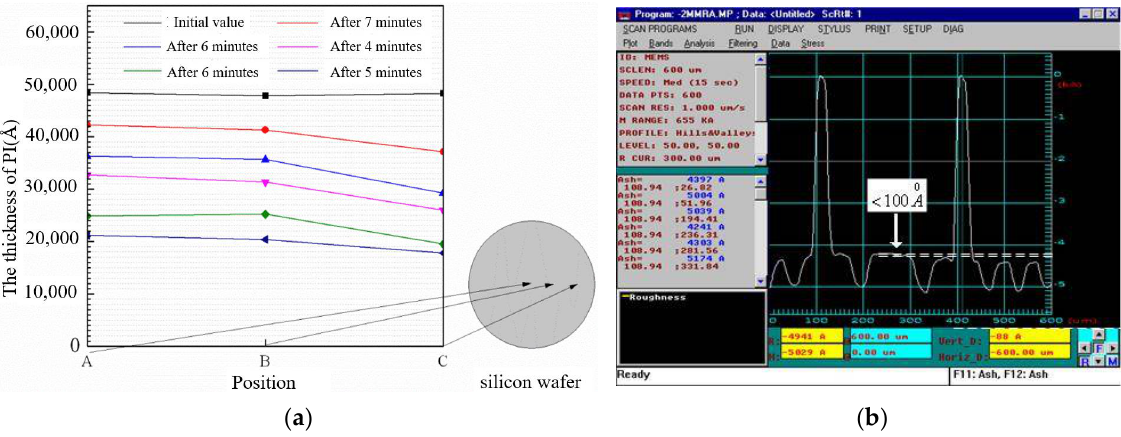
Figure 9. ( a ) PI thickness changes before and after CMP ( b ) Roughness test results.